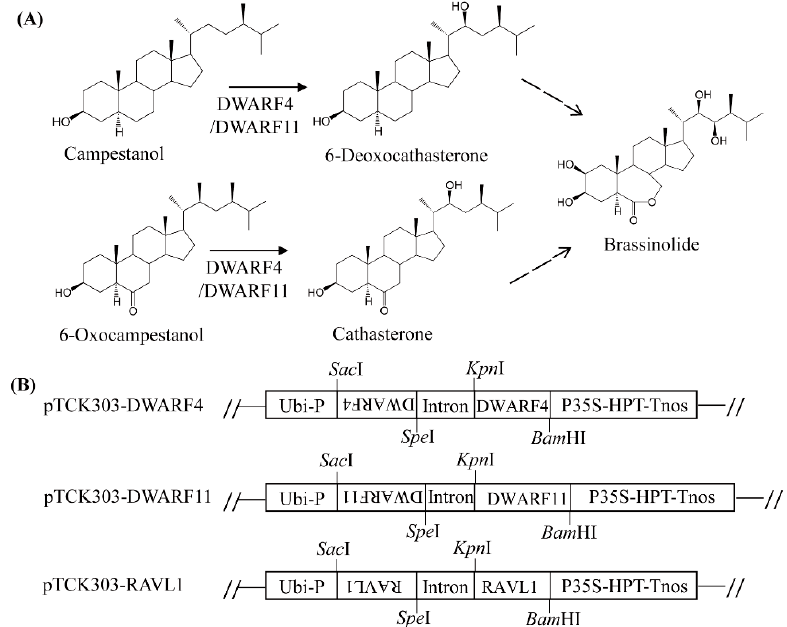
Figure 3. Brassinosteroid biosynthetic pathway and schematic diagram of binary vector. ( A ) Brassinosteroid biosynthesis and DWARF4 and DWARF11 enzymes. ( B ) Schematic diagram of pTCK303:DWARF4, pTCK303:DWARF11, and pTCK303:RAVL1 binary vectors. GenBank accession numbers of DWARF4 , DWARF11 , and RAVL1 are AB206579, AK106528, and Os04g0581400. Ubi-P, maize ubiquitin promoter; P35S, 35 S cauliflower mosaic virus 35S promoter; HPT, hygromycin phosphotransferase; Tnos, nopaline synthase terminator.